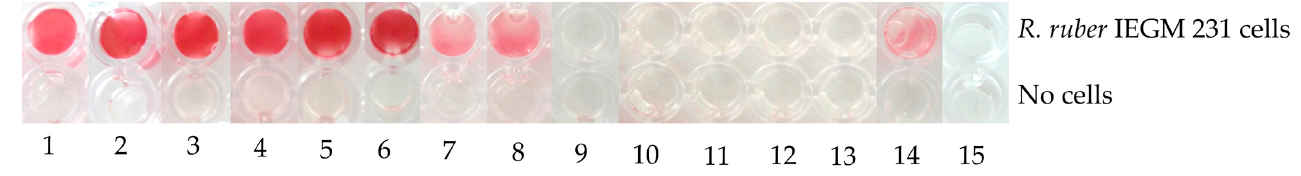
Figure 5. Growth of R. ruber IEGM 231 in the presence of aniline, substituted pyridine derivatives, aromatic acids, and coumarin determined with INT staining. Substrates: 1—25.0 mM D-glucose (biotic control); 2—12.5 mM aniline; 3—25.0 mM 2-picoline; 4—25.0 mM 3-picoline; 5—25.0 mM 4-picoline; 6—25.0 mM 2,6-lutidine; 7—25.0 mM 2-hydroxypiridine; 8—25.0 mM 4-hydroxipyridine; 9—3.2 mM quinoline; 10—25.0 mM o- phthalic acid; 11—0.1 mM m- phthalic acid; 12—0.1 mM p- phthalic acid; 13—25.0 mM salicylic acid; 14—25.0 mM coumarin; 15—the mineral medium RS without substrate supplementation (control for oligotrophic growth); no cells—the mineral medium RS with aromatic compounds without R. ruber IEGM 231 cells (abiotic control).